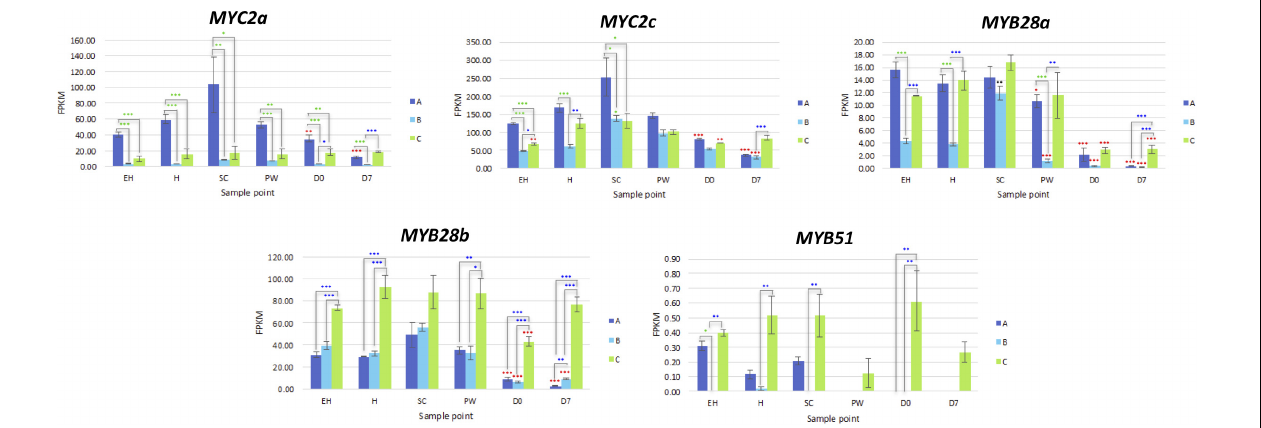
FIGURE 8 | RNAseq expression data (FPKM) for glucosinolate transcription factors in three elite inbred lines of Eruca sativa ( A , dark blue; B , light blue; C , green). Standard errors of the mean expression values are represented by error bars. Asterisks denote levels of significance of up and down regulation within sample points (between each inbred line) and relative to the point of harvest for each respective sample point: * p ≤ 0.05; ** p ≤ 0.01; *** p ≤ 0.001; green, significant up regulation between lines A , B , and C ; blue, significant down regulation between lines A , B , and C ; black, significant up regulation relative to H ; red, significant down regulation relative to H . EH , early harvest; H , harvest; SC , second harvest; PW , pre-wash; D0 , post-wash; and D7 , 7-day shelf